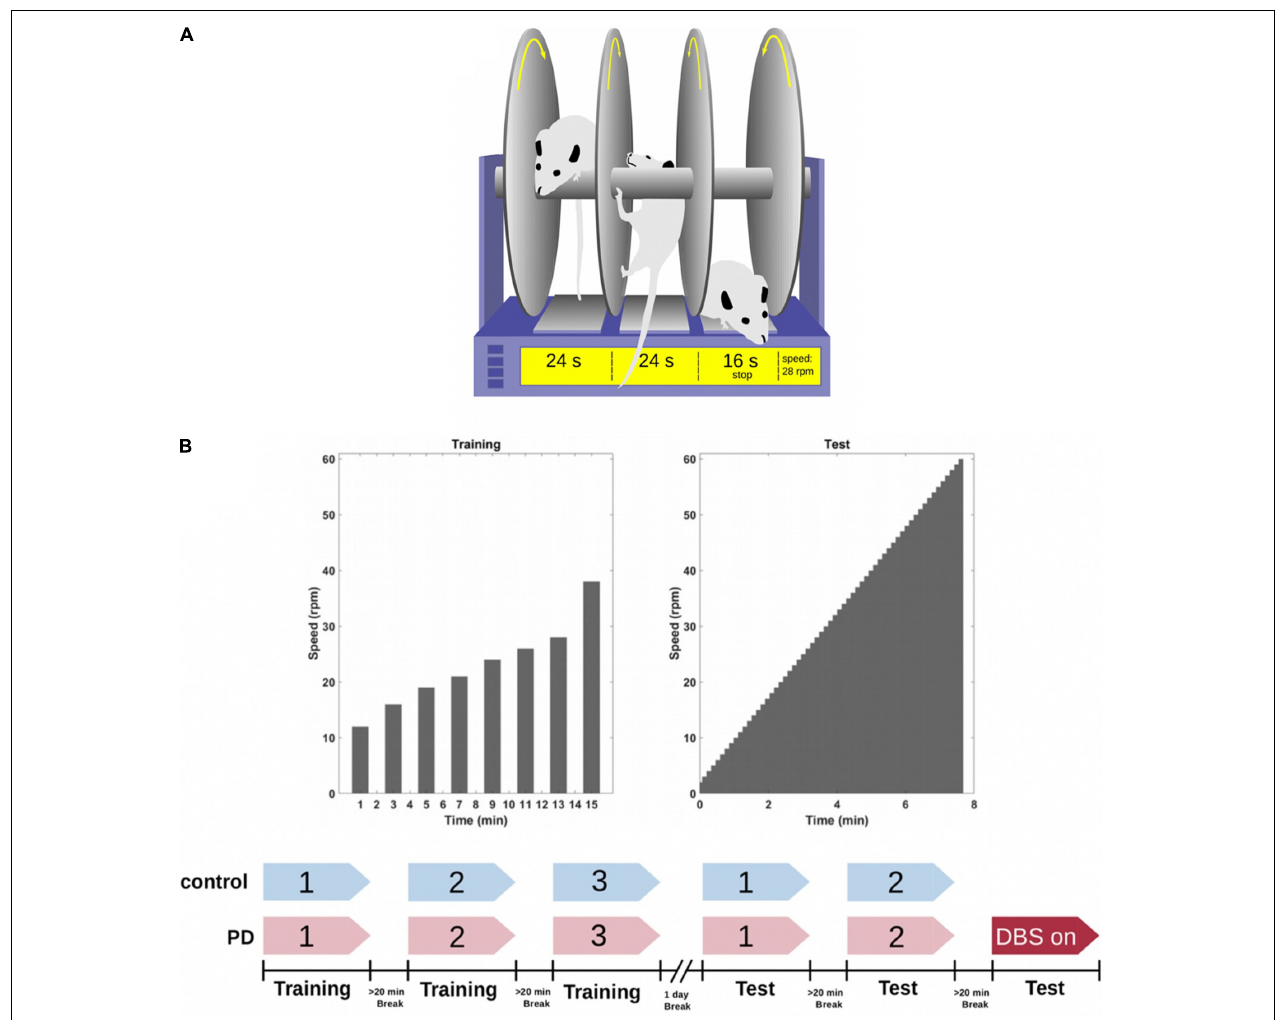
FIGURE 4 | (A) The rotarod is a device consisting of a rotating rod on which rats have to walk without falling for as long as they can. A timer records how long the rats walk on the rod before they fall and trip a switch which stops the timer. (B) All the animals ( n = 25) were trained on the rotarod 1 day prior to the test day. They trained for three sessions (with a maximum duration of 60 s) with a 20 min break between each session. On the next day, both the sham and PD group performed two sessions of testing without DBS. A subgroup of the PD rats ( n = 7) performed a third round while receiving DBS treatment. The other subgroup performed the third round without DBS ( n = 6). Figure adapted from Mottaghi